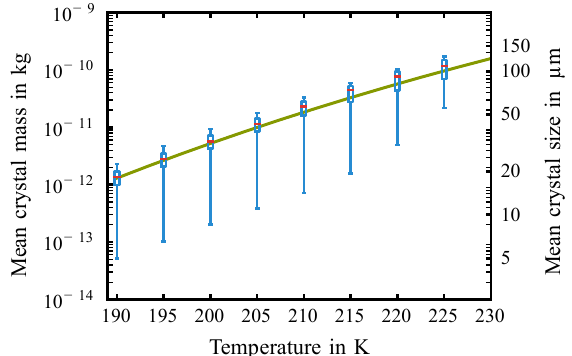
Figure 10. Mean ice crystal mass m as a function of temperature. For the equilibrium state x 0 , values of m depends only slightly on the vertical velocity, the curve covers the area that corresponds to vertical velocities 0 . 001ms − 1 ≤ w ≤ 0 . 05ms − 1 . Additionally, box-and-whisker plots indicate median, 25th/75th percentiles, and minimum/maximum values, respectively, for the limit cycle regime.